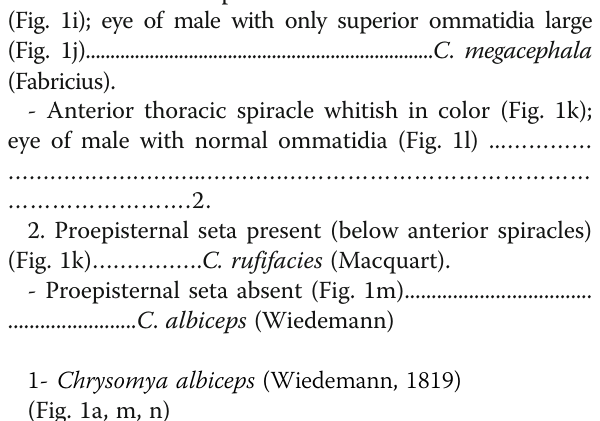
(Fig. 1k) …………… . C. rufifacies (Macquart). - Proepisternal seta absent (Fig. 1m)...................................